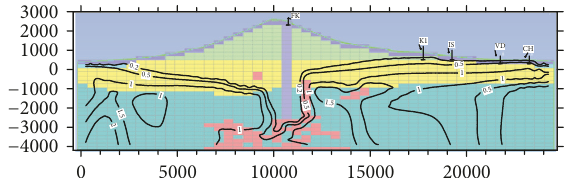
Figure 15: Distributions of modeled CO 2 partial pressures (bar) (TOUGH2-EOS2) (CO2-8 + 2I). Horizontal and vertical axes are labeled in meters.